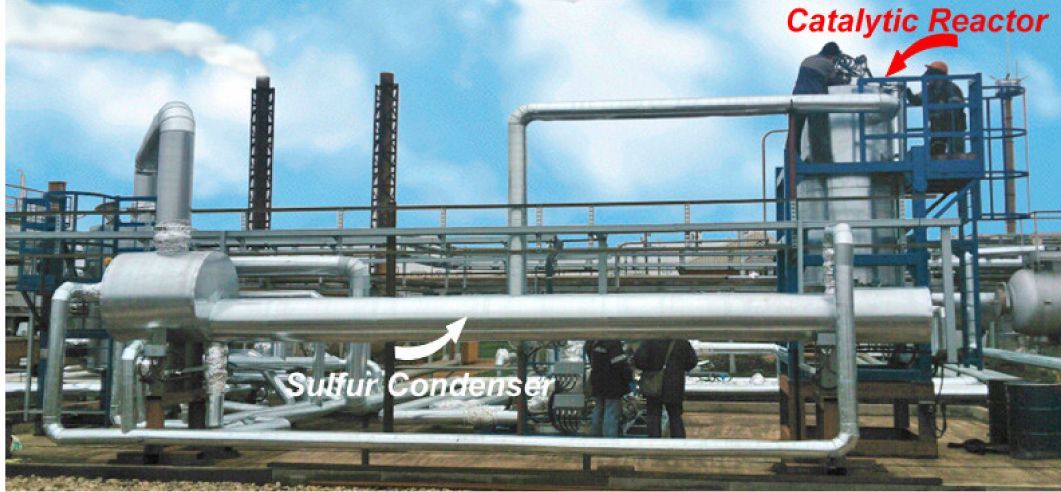
Figure 29. Industrial APG purification plant by direct catalytic